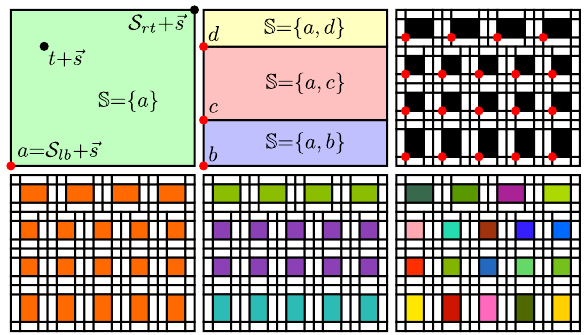
Figure 6: In the upper row, we show the application of several split rules. During the subdivision, we put several random seeds ( a, b, c, d ) onto the stack S . In the bottom row, we apply the Rand operator to all black scopes that are shown in the upper right fa- cade. In this example, each target rule that can be chosen by Rand will apply an operator which fills the whole scope with a unique color. Using 2 (bottom left facade) or 1 (bottom middle facade) as first parameter will group the elements according to the ran- dom seed on the current stack. If the first parameter of Rand is 0 , every element uses another target rule since the bottom left corner varies from scope to scope (bottom right facade).